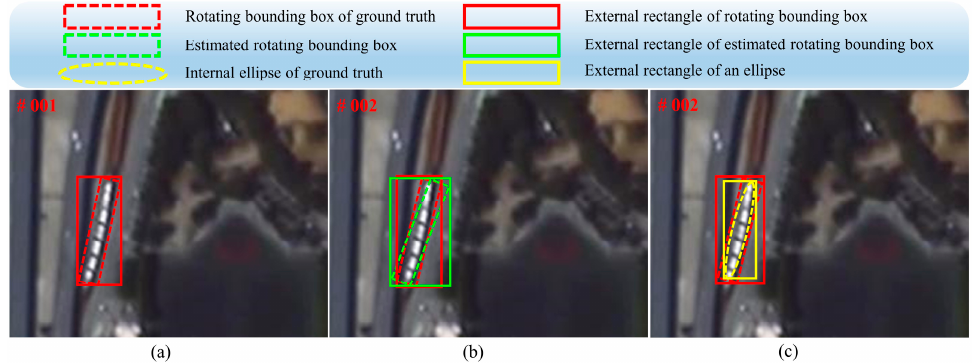
Figure 6. Visualization of different bounding boxes. ( a ) shows the external rectangle of the rotating bounding box. ( b ) shows the effect of angle deviation on the external rectangle. ( c ) presents the internal-shrinkage strategy for evaluation.